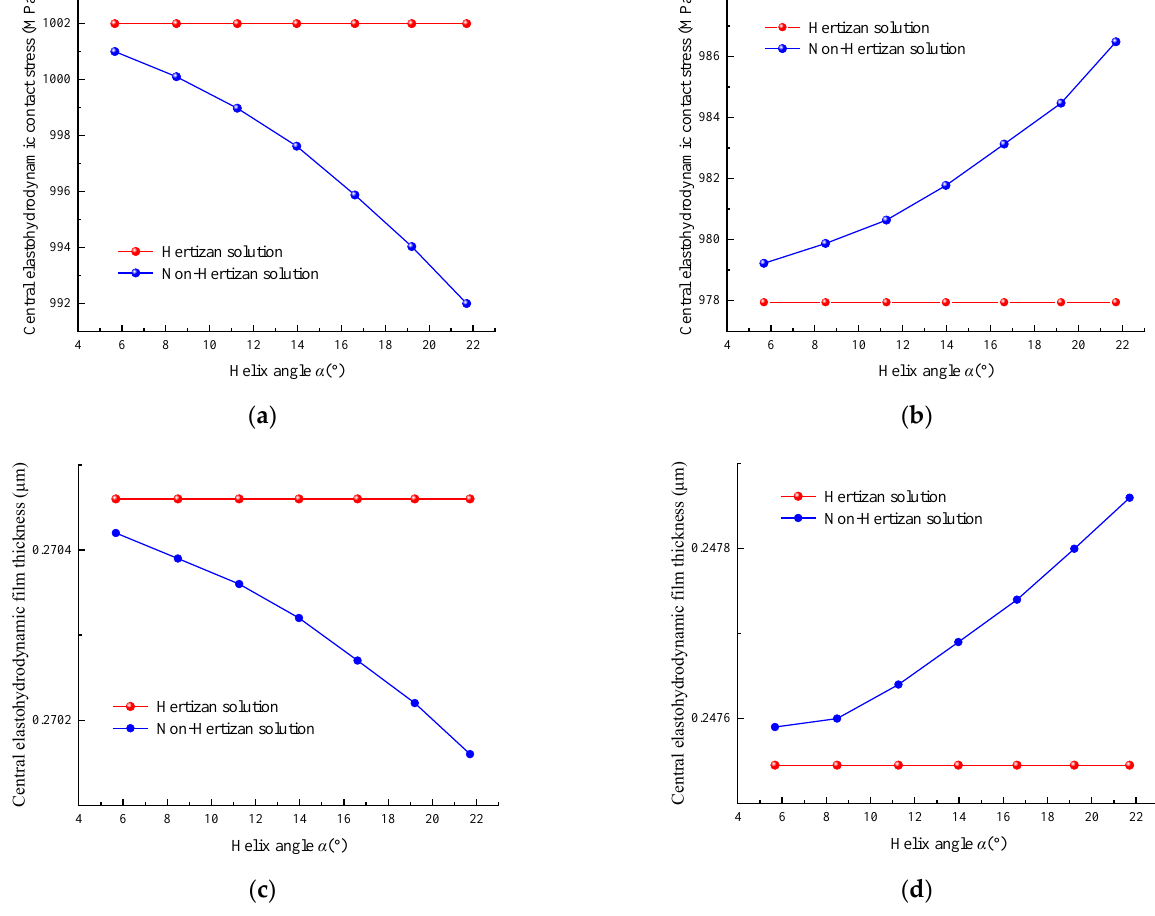
Figure 11. Comparison of the elastohydrodynamic characteristics between the Hertzian solution and non-Hertzian solution. ( a ) Central elastohydrodynamic contact stress of point A . ( b ) Central elastohydrodynamic contact stress of point B . ( c ) Central elastohydrodynamic film thickness of point A . ( d ) Central elastohydrodynamic film thickness of point B .